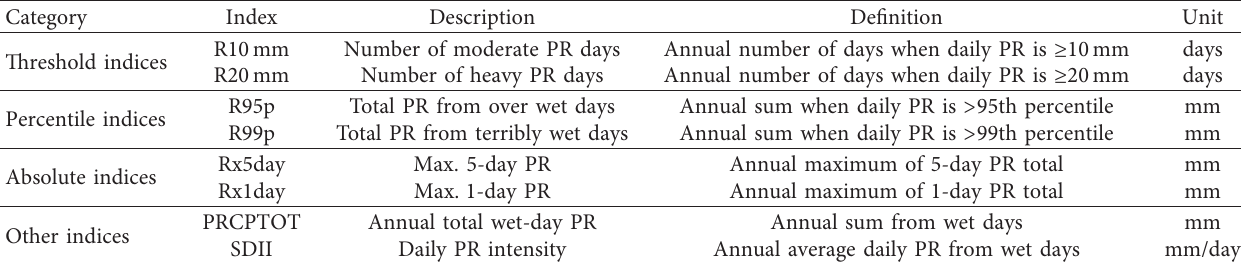
Table 1: Summary of eight precipitation indices. Note: PR is precipitation; wet days are when daily PR is ≥ 1.0 mm. Category Index